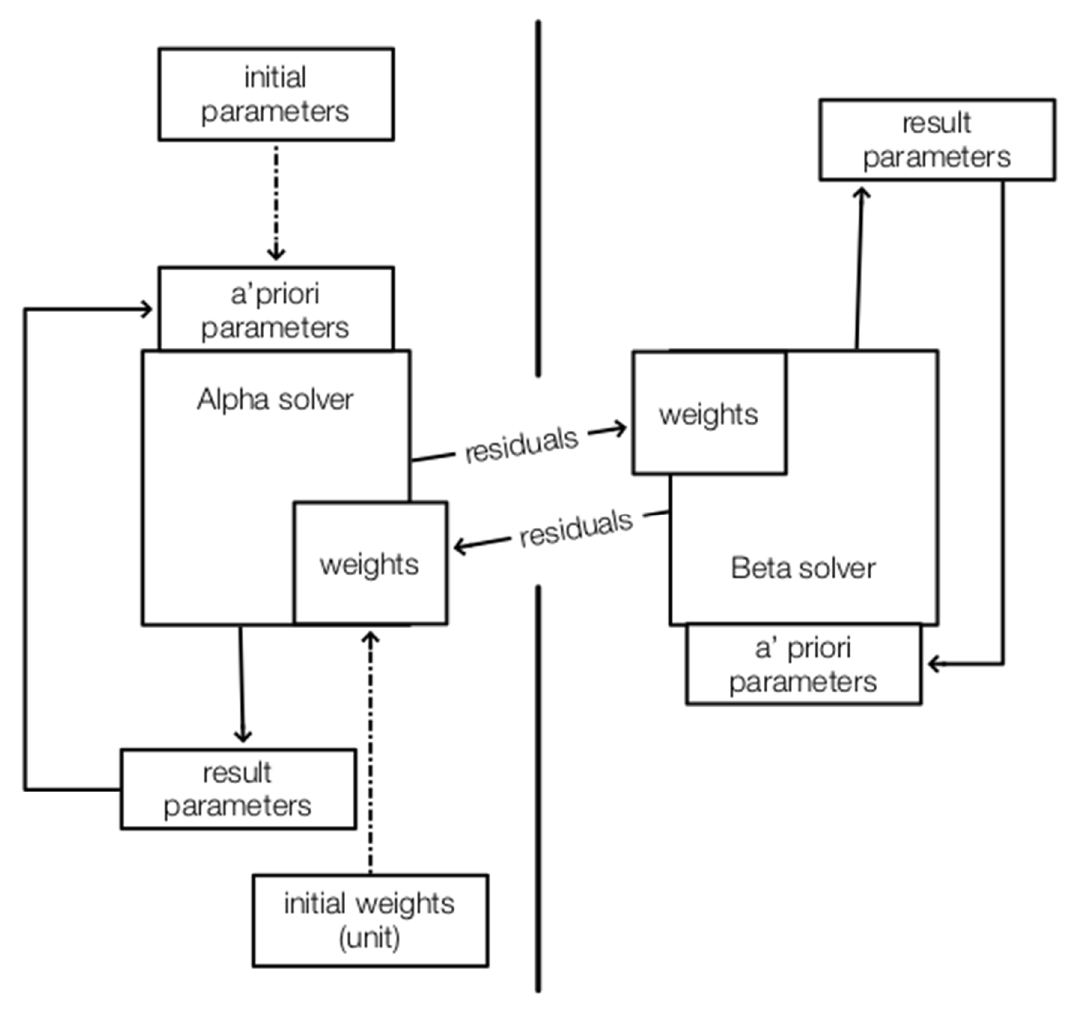
Figure 7. Block diagram of Msplit estimation.